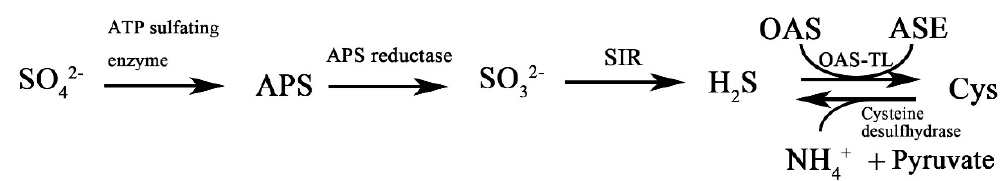
Figure 1. Synthesis of H 2 S in plant cells [15]. APS: 5’-adenylylsulfate; SIR: sulfite reductase. OAS: O-acetyl serine; OAS-TL: O-acetyl-L-serine (mercaptan) lyase; ASE: acetate; Cys: cysteine.